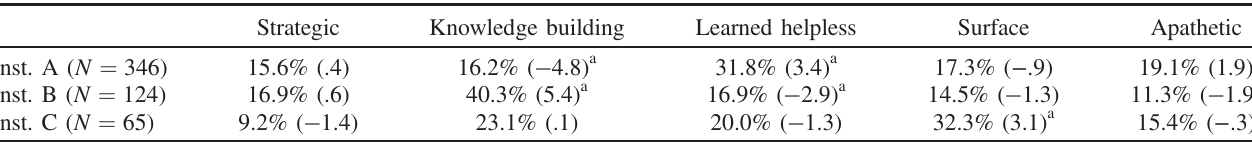
TABLE IX. Frequency of learning profiles across institutions. Row percentages and adjusted residuals (in parentheses) given in each cell. Strategic Knowledge building Learned